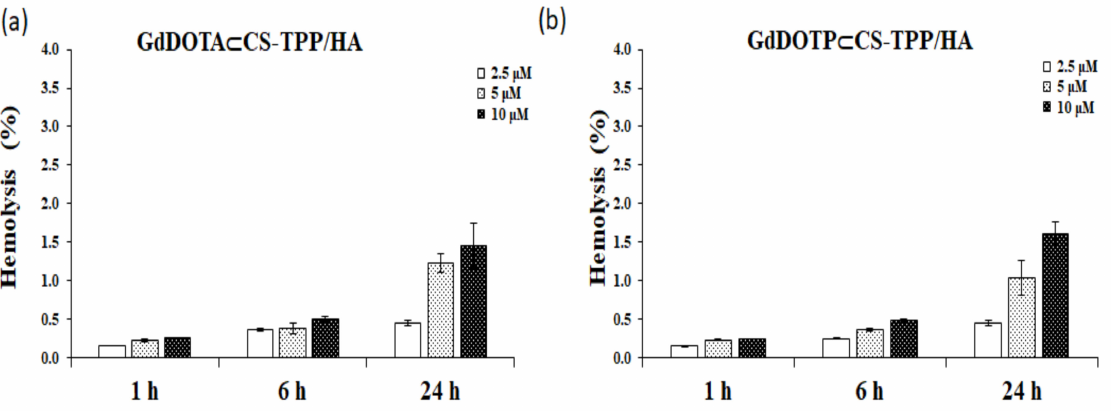
Figure 5. The percentage of hemolysis after 1, 6 and 24 h of incubation with ( a ) GdDOTA ⊂ CS- TPP/HA and ( b ) GdDOTP ⊂ CS-TPP/HA NGs, at doses of 2.5, 5 and 10 µ M. Data are expressed as mean ± SD ( n = 3). As a positive (100% hemolysis) and negative (0% hemolysis) controls, supernatants resulting from red blood cells treated with Triton X-100 1% and physiological serum (0.9% NaCl) respectively have been used. The maximum hemolysis rates induced after the 24-h interval were 1.45% ± 0.29% for GdDOTA ⊂ CS TPP/HA and 1.61% ± 0.15% for GdDOTP ⊂ CS-TPP/HA,